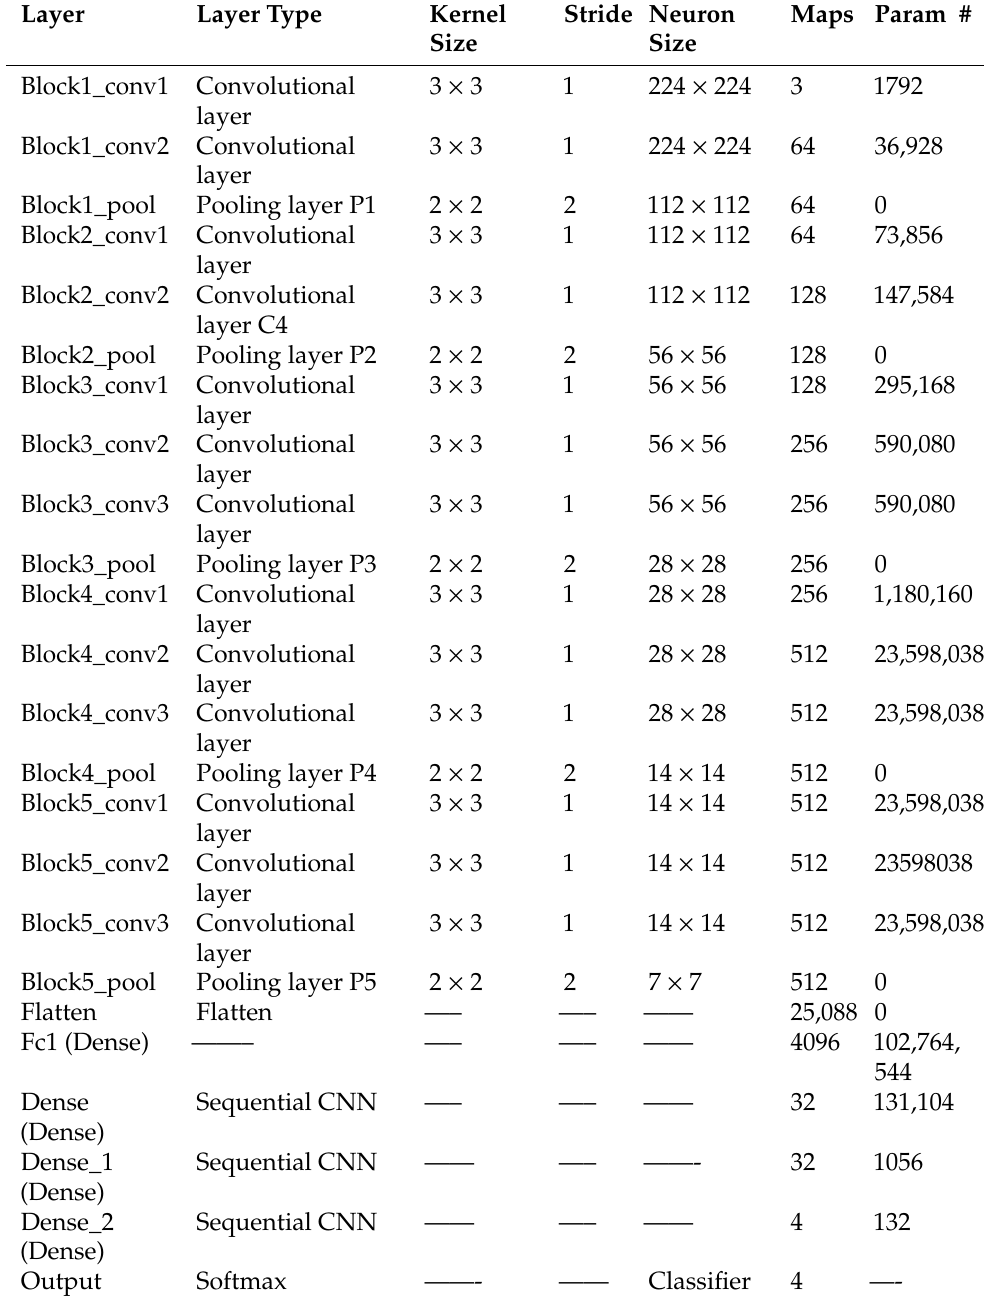
Table 2. The related parameters of the implemented